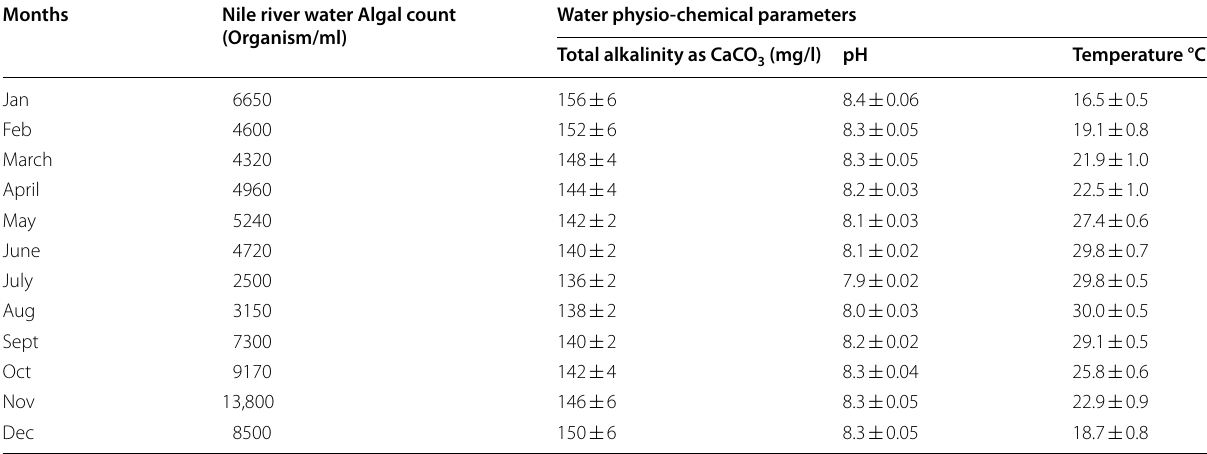
All data represented means of three replicates